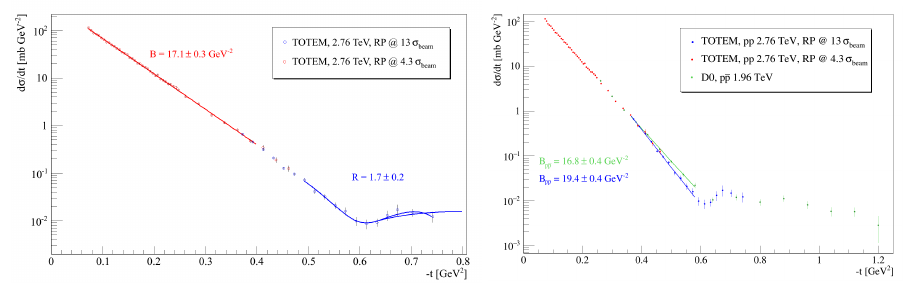
Figure 6. Left panel: Di ff erential cross-section of elastic pp scattering measured at the LHC energy of √ s = 2 . 76 TeV by TOTEM, as compared to third order polynomial fits in the dip and bump region [4]. The nuclear slope parameter is B = 17 . 1 0 . 3 GeV − 2 , the maximum / minimum ratio is R = 1 . 7 0 . 2 ± ± for this pp dataset. Right panel: Di ff erential cross-section of elastic pp scattering measured at the LHC energy of √ s = 2 . 76 TeV by TOTEM [4], as compared to D0 data on elastic proton-antiproton scattering at the Tevatron energy of √ s = 1 . 96 TeV [8]. The nuclear slope parameter "swings" ie t increases at about 0 . 4 GeV − 2 up to B pp = 19 . 4 0 . 4 GeV − 2 in pp at √ s = 2 . 76 TeV, while it − ≈ ± t remains within errors constant in the pp dataset of D0 at the comparable √ s = 1 . 96 TeV in the same − region, B pp = 16 . 8 0 . 4 GeV − 2 . The maximum / minimum ratio is R = 1 . 0 0 . 0 for the D0 pp dataset. ± ± Figure from ref. [4].